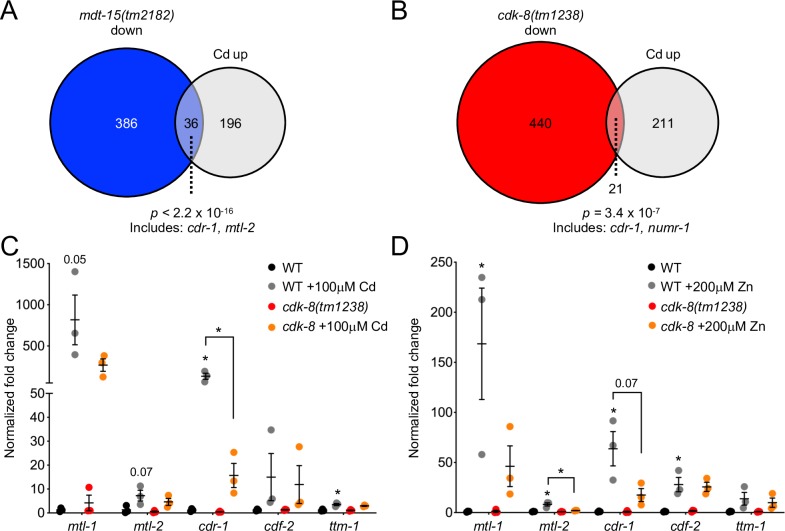
Mediator subunits mdt-15 and cdk-8 are required for cadmium and zinc stress responses.[A] The Venn diagram depicts the overlap between genes downregulated in the mdt-15(tm2182) mutant and genes induced by cadmium (identified in [43]). Statistical significance was assessed by Fisher’s exact test. Shared genes include cdr-1 and mtl-2, which are known to function in cadmium biology [40,41]. See S1 Table for details. [B] The Venn diagram depicts the overlap between genes downregulated in the cdk-8(tm1238) mutant and genes induced by cadmium. Statistical significance was assessed by Fisher’s exact test. Shared genes include cdr-1 and numr-1, which are known to function in cadmium biology [40,42,44]. See S1 Table for details. [C-D] qRT-PCR analysis of zinc and cadmium-responsive genes in wild-type (WT) and cdk-8(tm1238) mutant worms grown on 100μM cadmium for 4 hours [C] or on 200μM zinc for 16 hours [D]. Graphs show fold induction, normalized to the average of unsupplemented WT mRNA levels. Error bars: SEM (n = 3 independent repeats). Statistical analysis: * p < 0.05, unpaired t-test comparing WT supplemented worms to WT supplemented worms, except for comparisons indicated by lines (note, only significant or near-significant (p < 0.075) values are shown).